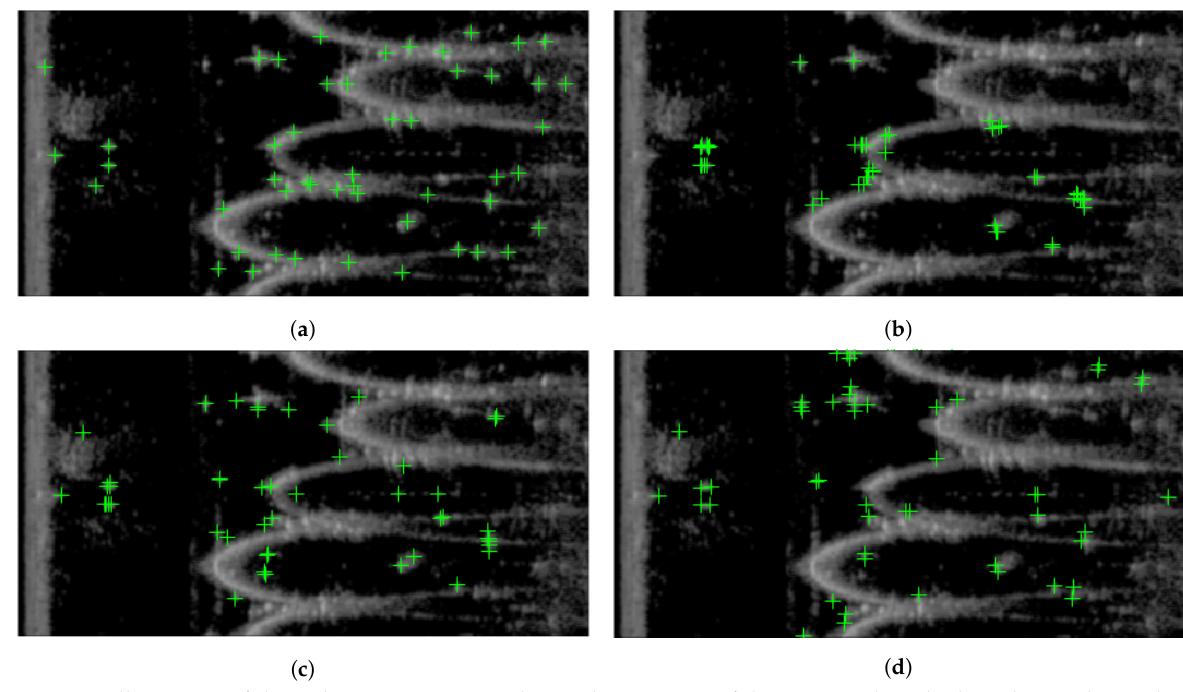
Figure 16. Illustration of the 50 best interest point detected in image 6 of dataset 2 with each algorithm under analysis. ( a ) Interest point detection with SURF algorithm, ( b ) interest point detection with ORB algorithm, ( c ) interest point detection with BRISK algorithm, and ( d ) interest point detection with SURF-Harris algorithm.